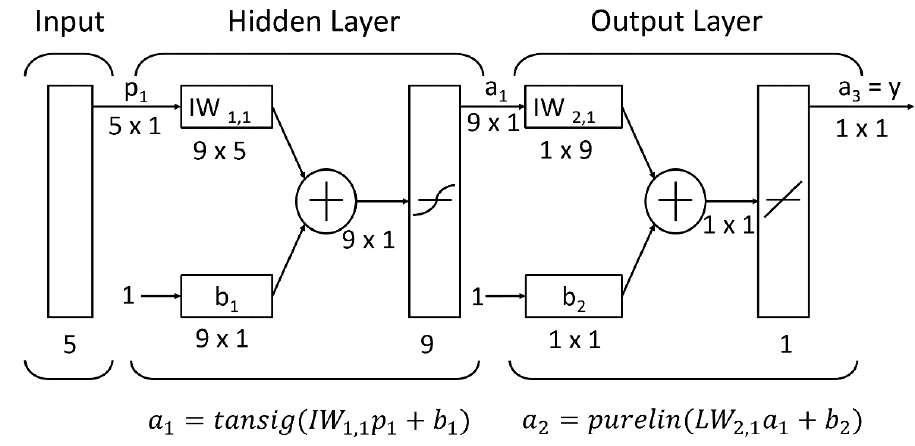
Figure 8. Multilayer networks with weight matrix. Table 4. Neural network constants.